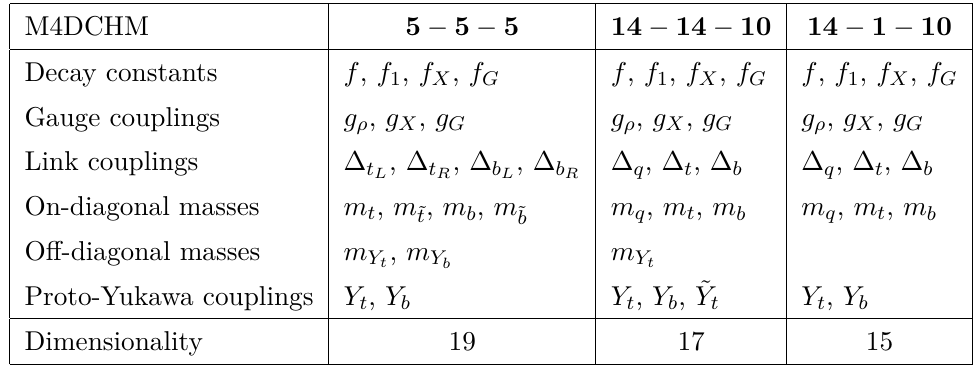
Table 2. Parameters present in each